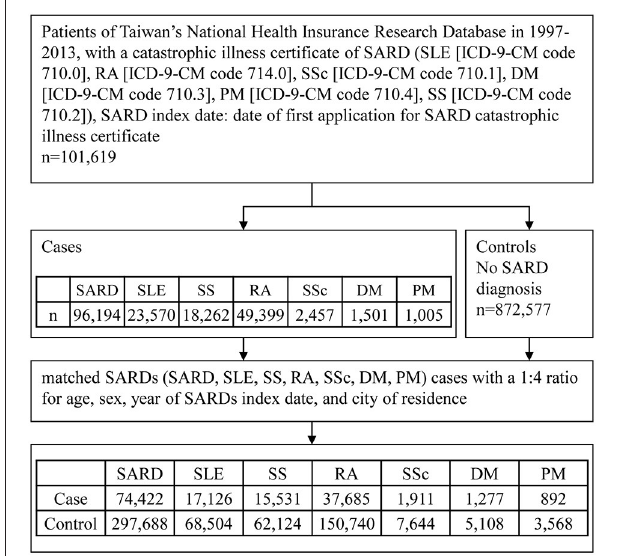
FIGURE 1 | Flowchart of study participant enrollment procedure. SARD, systemic autoimmune rheumatic disease; SLE, systemic lupus erythematosus; RA, rheumatoid arthritis; SSc, systemic sclerosis, scleroderma; DM, dermatomyositis; PM, polymyositis; SS, Sjogren’s syndrome; ICD-9-CM, International Classification of Diseases, Ninth Revision, Clinical